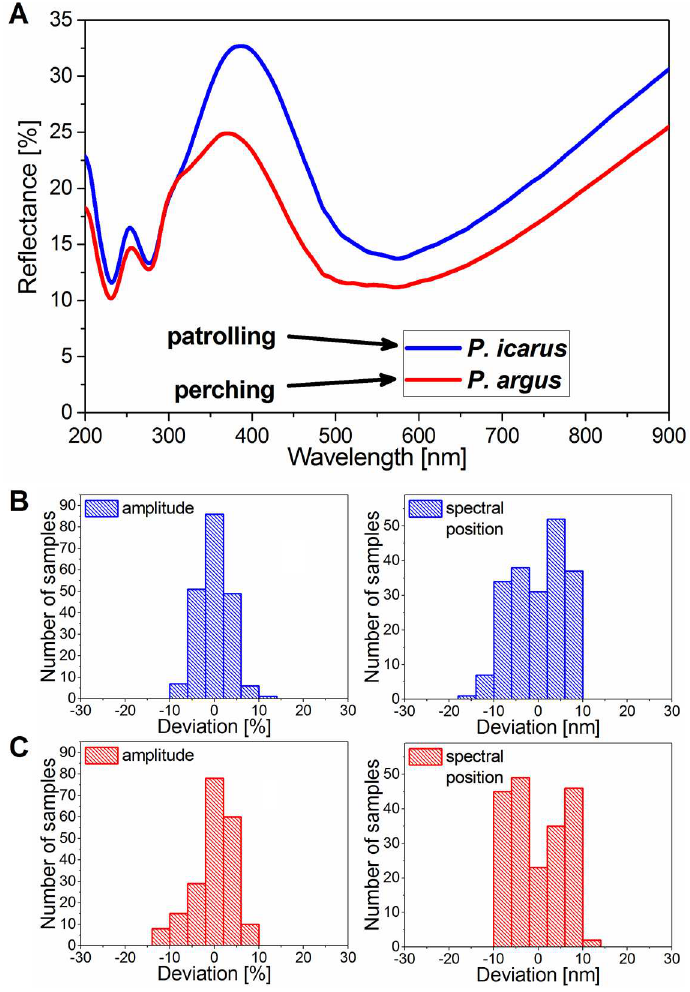
Fig 9. (A) Averaged reflectance spectraand histograms of the amplitude and spectral position deviations of (B) Polyommatus icarus and (C) Plebejus argus males measured with the integrating sphere light-collection setup (n = 200 each). (A) In additionto the spectral differences, such as the peak positionshift and the shoulderin the P . argus spectra (shown in Fig 2), an intensity difference betweenthe two species can be observed. (B, C) For both species,the distributionsof the peak amplitudedeviations have Gaussian-like shapes, while the spectral positiondistributionsshow a sharp cut-off at ± 10 nm deviation, indicating that no individuals with outlier color were